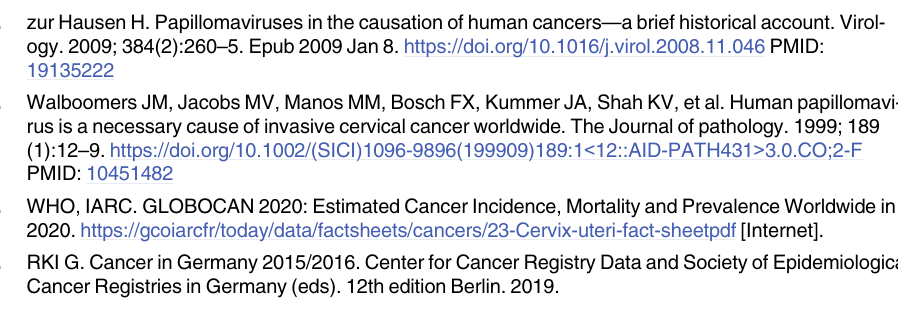
S9 Table. 95% Confidence interval calculations Fig